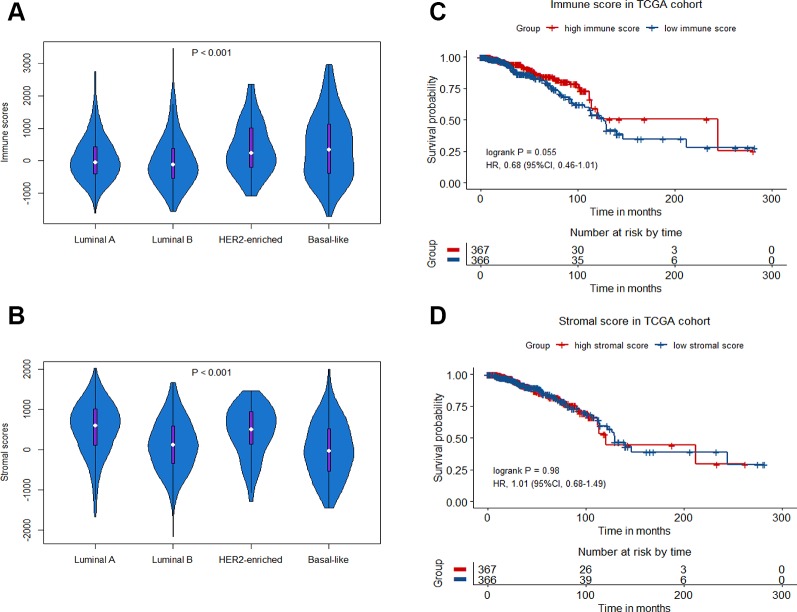
Immune scores and stromal scores in breast cancer. Violin-plot showing the distribution of immune scores (A) and stromal scores (B) among different breast cancer molecular subtypes. Kaplan−Meier curves of overall survival (OS) among high or low risk groups based on immune scores (C) and stromal scores (D) in the TCGA cohort.